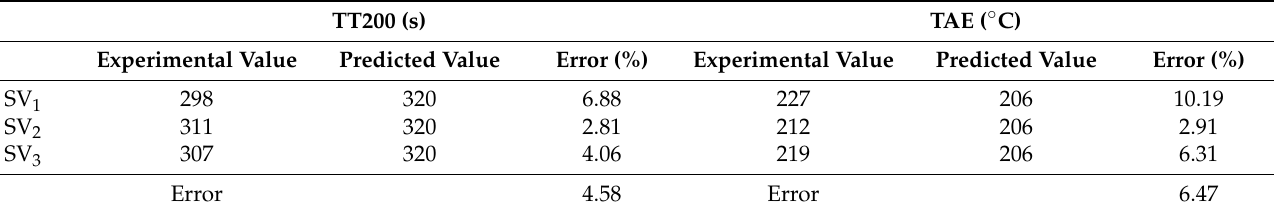
Table 6. Experimental validation for the fire resistance